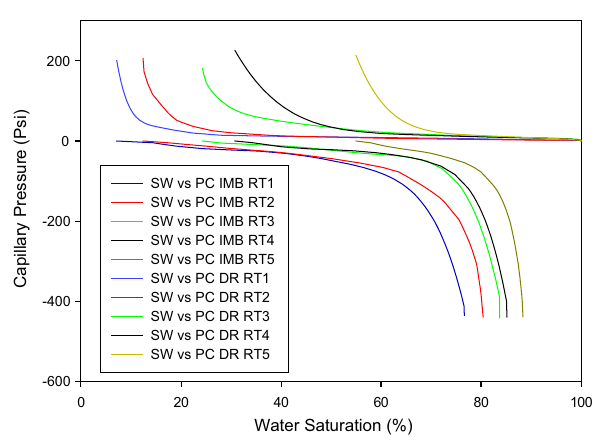
Fig. 7 Capillary pressure curves for water–oil imbibition process along with drainage curves